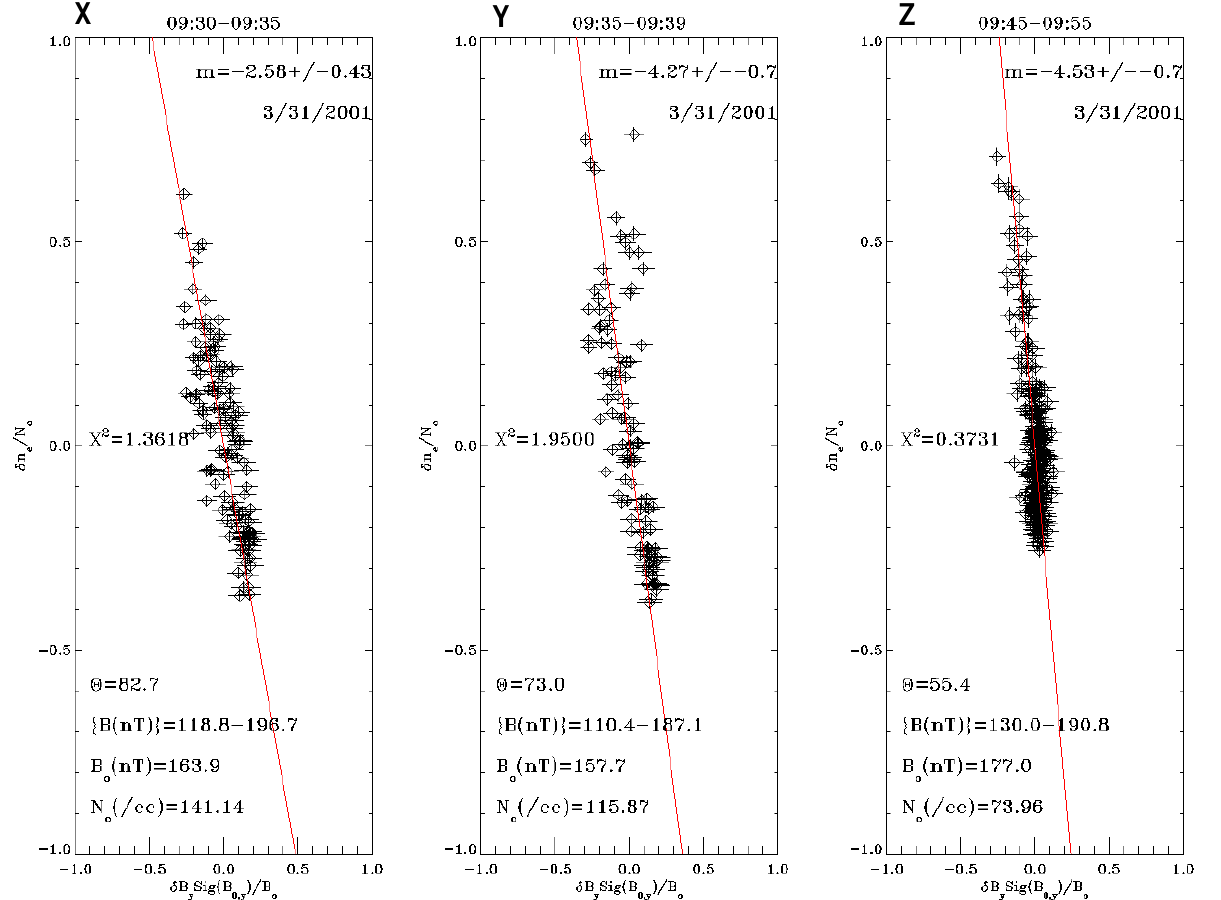
Fig. 11. Linear regression fits for three intervals of 31 March 2001, labeled X, Y, and Z in Fig. 1. Normalized changes in density are plotted as functions of normalized changes in the maximum variance component of B . B o and N o represent values of B and N at the nominal fit zero of the plane wave and are constrained to be within the interval. The actual zero may lie outside the interval. The function Sig(x), − 1 for X< 0 and + 1 for X> 0, is used to rectify the sign of δB so that negative values of the resulting slope represent slow-mode solutions. Sig(0) = 0. The reported slope m (related to α in Eqs. (1) and (2)) is M/sin( 2 b k ), where M represents actual slopes obtained from the plotted lines. See Scudder et al. (2003) for more